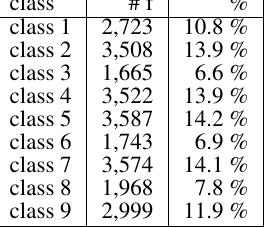
Table 3. Sizes of clusters for the ”roads”